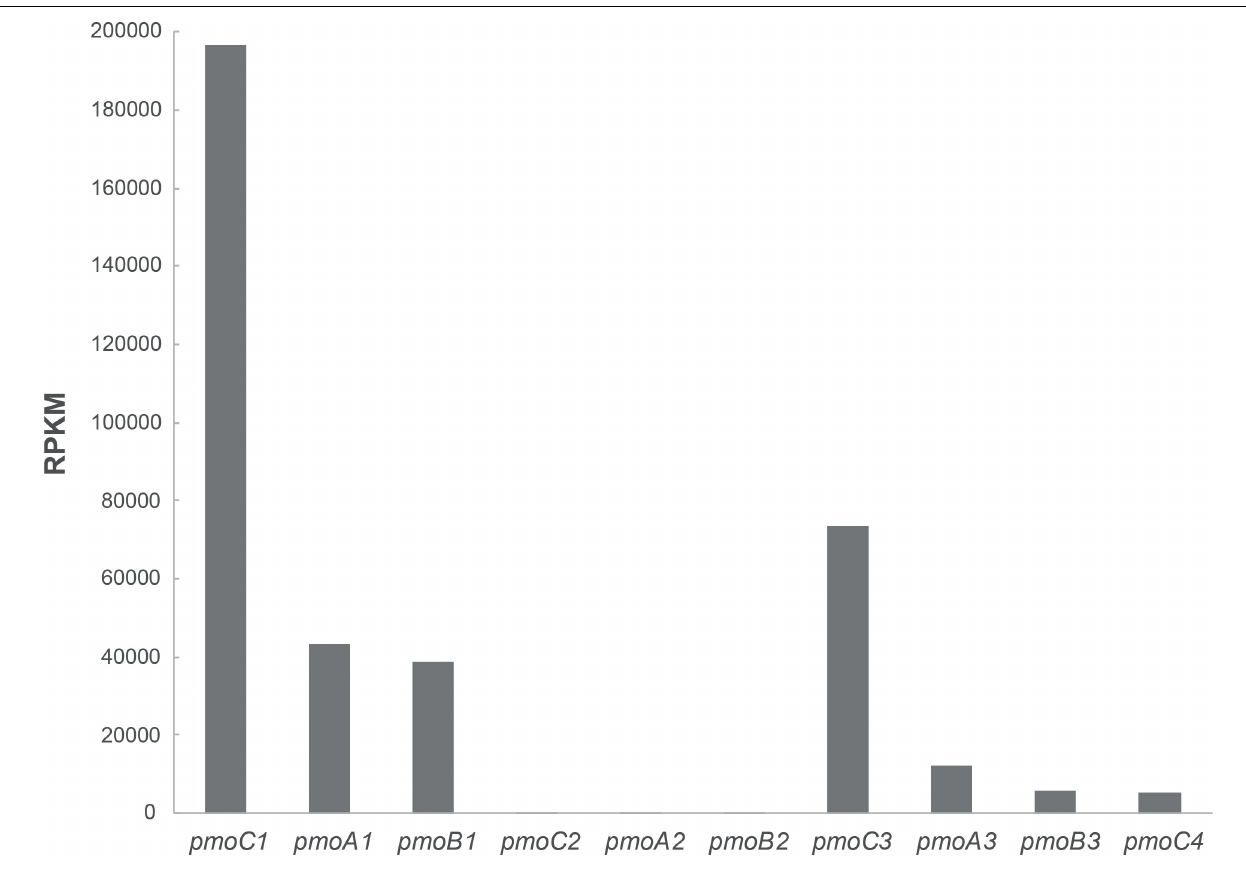
FIGURE 3 | Transcriptome analysis of pMMO encoding operons in M. fumariolicum SolV grown on methanol and ethane. Expression values are reported as RPKM and they represent the average over two